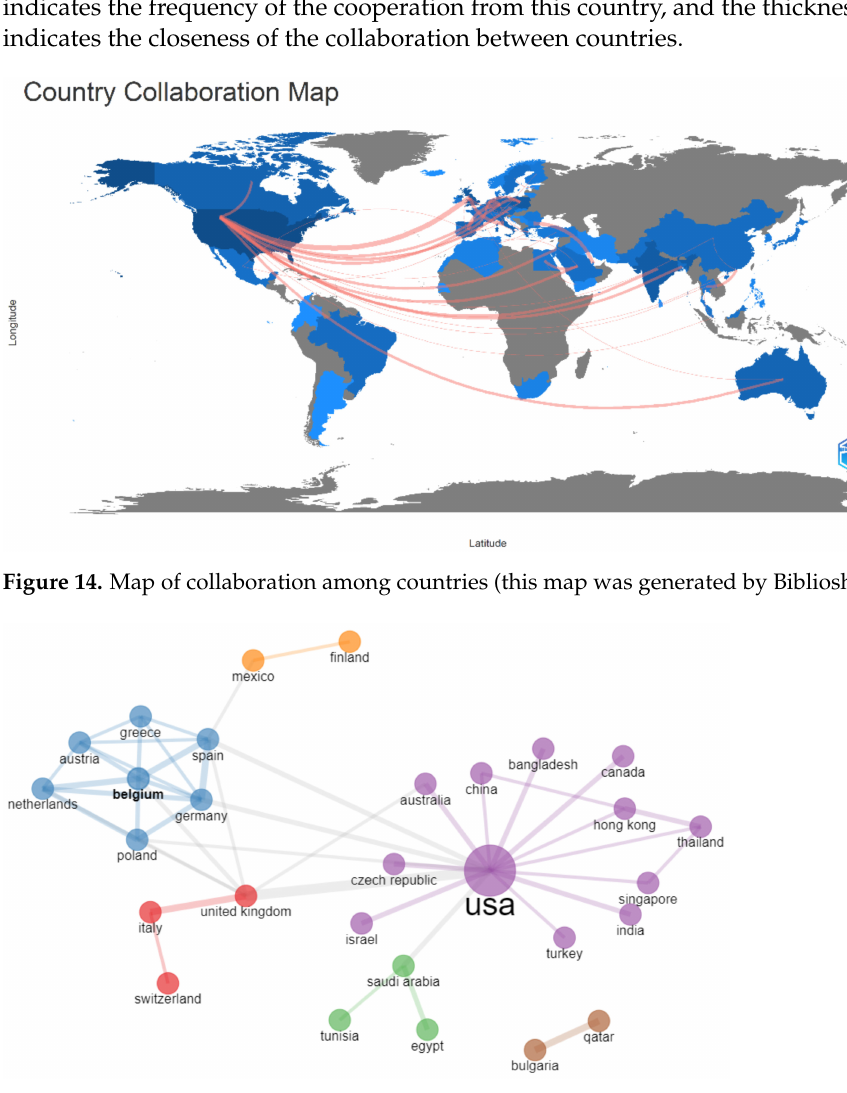
Figure 15. Social network of collaboration at the country level (this network was generated by